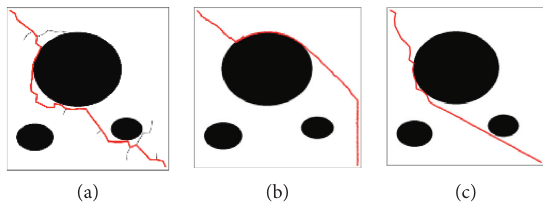
Figure 4: Map 1 running path diagram. (a) RRT. (b) ACO. (c) Ant colony optimization RRT.